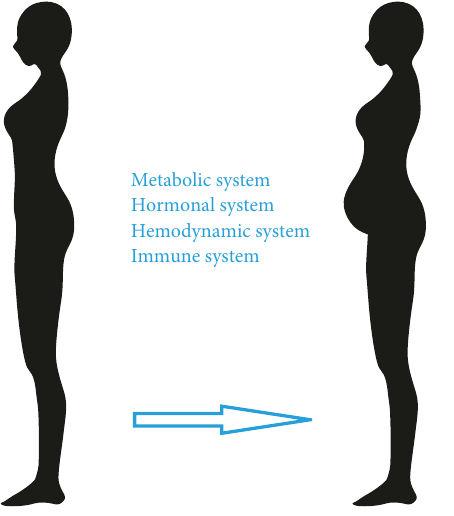
Figure 1: Changes of systems during pregnancy.